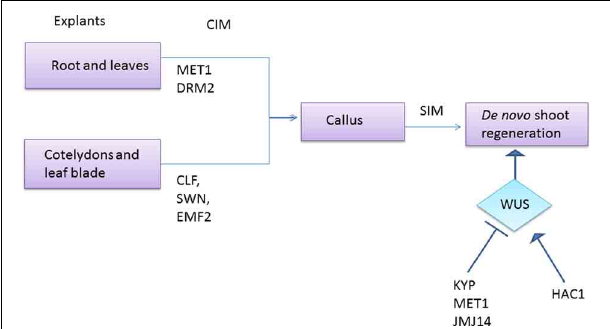
FIGURE 6 | Role of epigenetic modifiers in de novo shoot formation. Explants from various parts of the plant are having different epigenetic modifiers to control gene expression during callus formation. When MET1 and DRM2 are involved in the callus formation from root and leaves, CLF , SWN , and EMF2 does the same in explants derived from cotyledon and leaf blade. Further control on shoot organogenesis is achieved by monitoring the expression of WUS , which is epigenetically inhibited by KYP, MET1 , and JMJ14 and is enhanced by HAC1